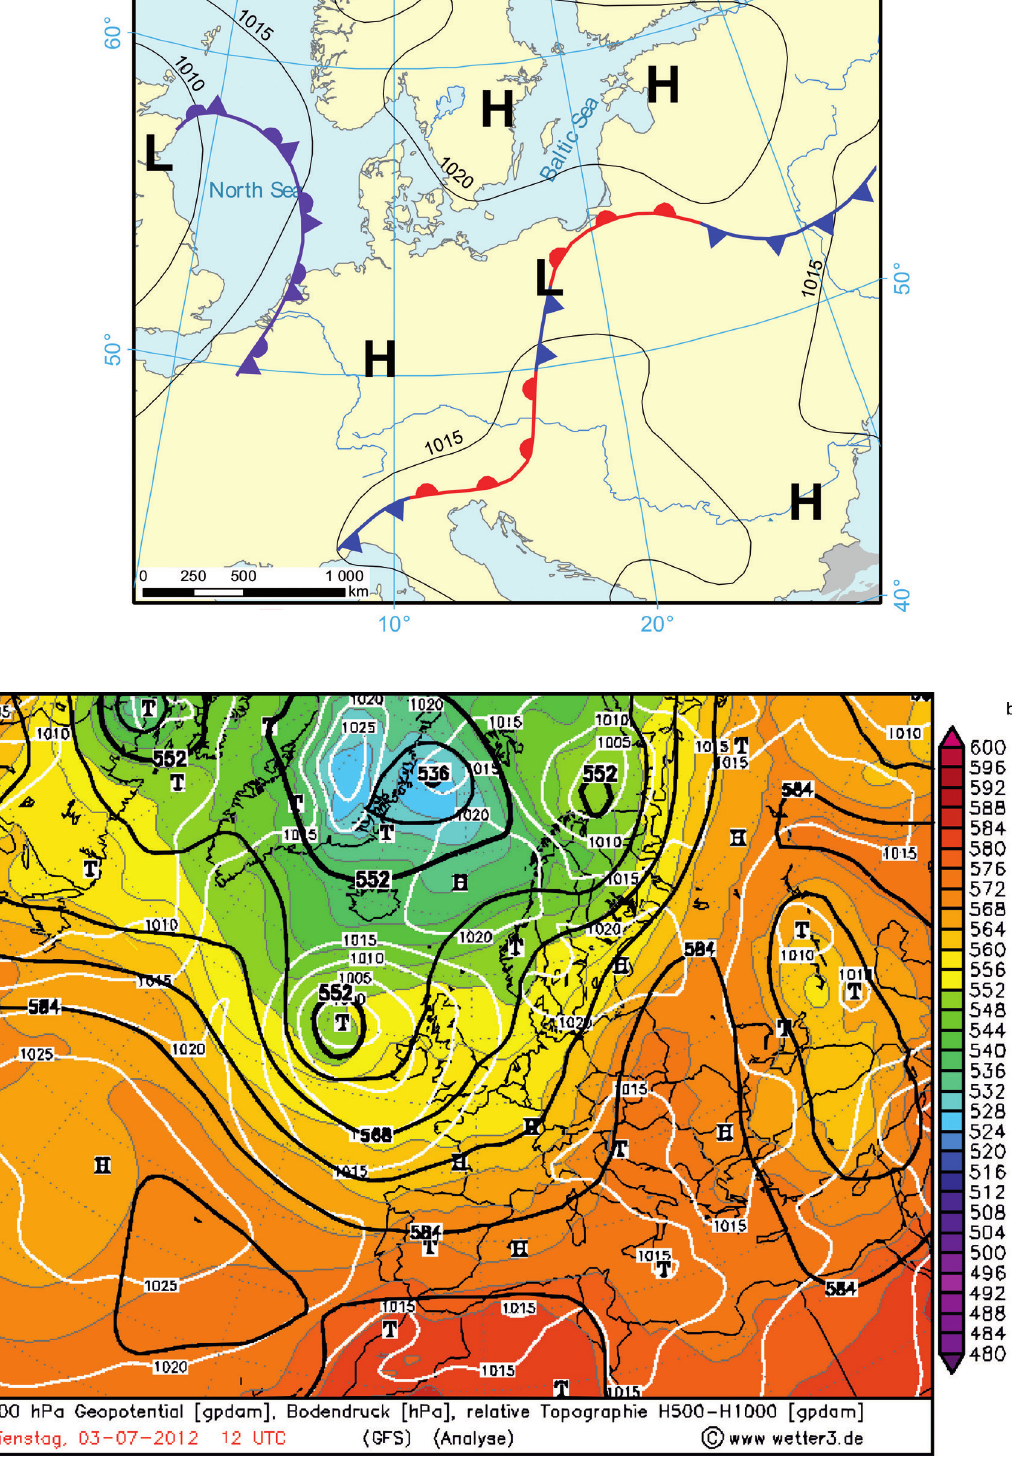
Fig. 6. Synoptic situation on 3rd July 2012 at 12 UTC a) – analysis chart created on the basis of Deutscher Wetterdienst data, b) – 500 hPa geopotential and surface pressure field (courtesy of